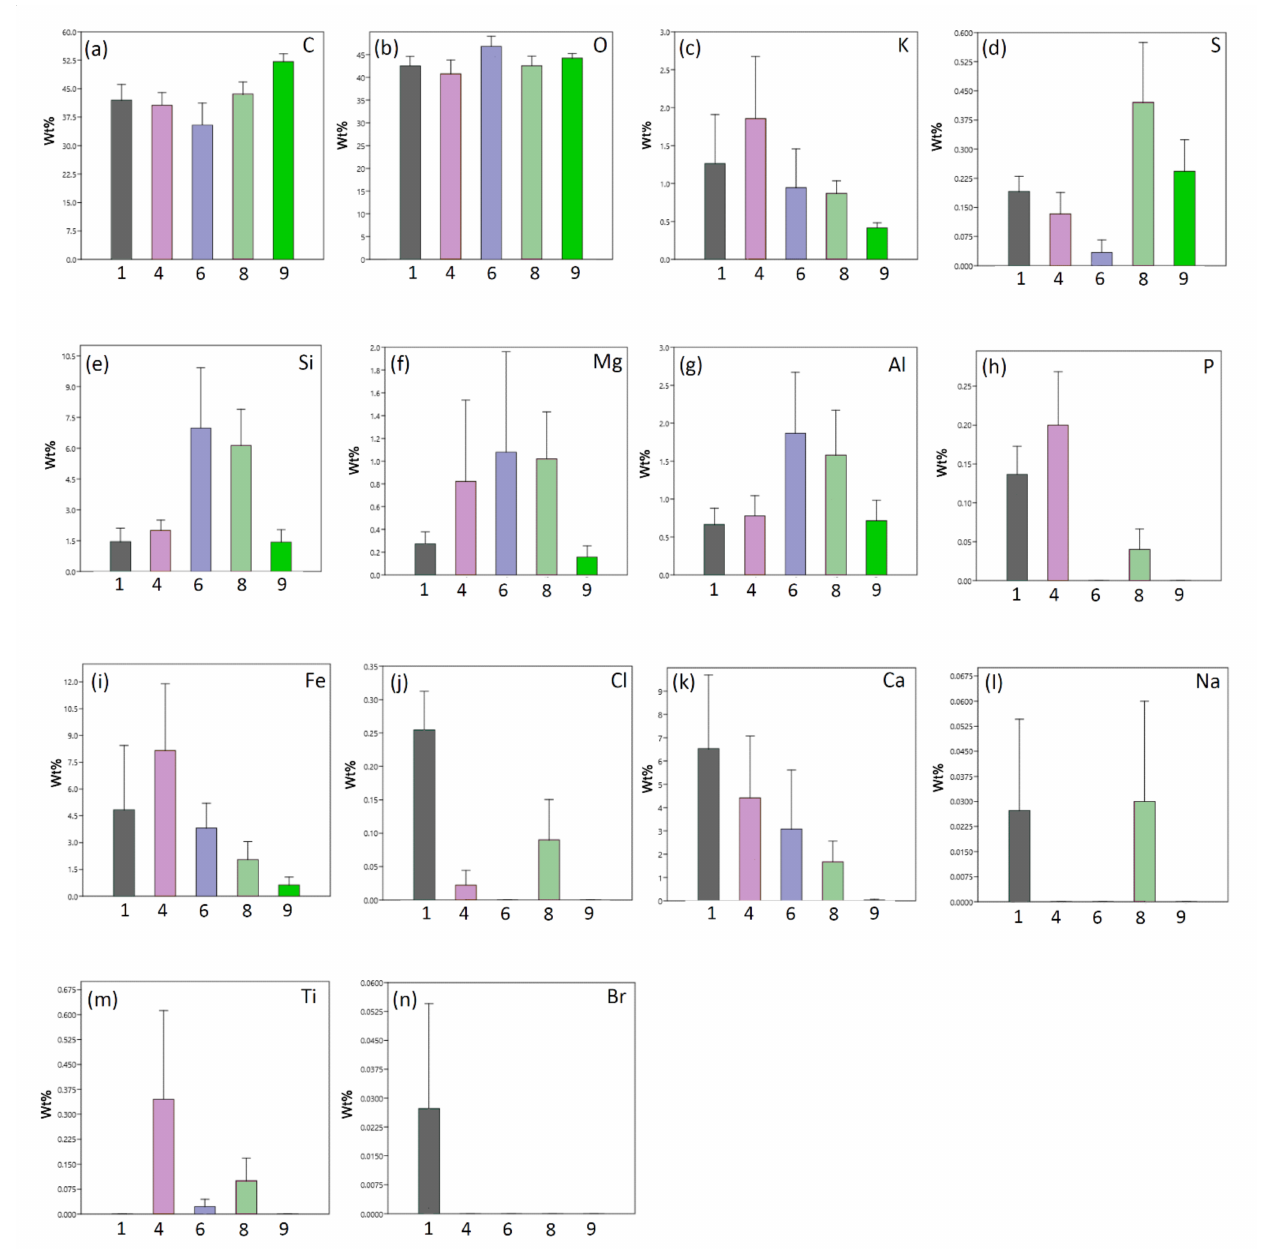
Figure 2. Averages weight percentages (Wt%) and standard errors of chemical elements found on samples of the lichen Xanthoria parietina obtained at sites along an urban–rural gradient in the city of L’Aquila (Central Italy): ( a ) carbonium; ( b ) oxygen; ( c ) potassium; ( d ) sulphur; ( e ) sili- con; ( f ) magnesium; ( g ) aluminium; ( h ) phosphorus; ( i ) iron; ( j ) chlorine; ( k ) calcium; ( l ) sodium; ( m ) titanium; ( n )